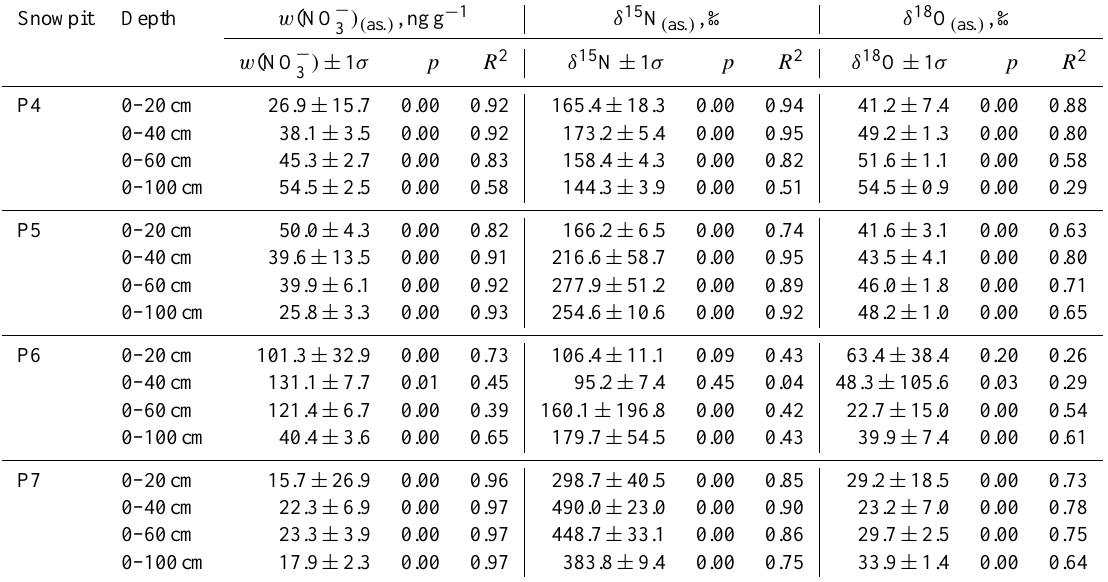
) , δ 15 N and δ 18 O of NO − Table 3. Asymptotic values of w (NO − calculated based on four different snow depth intervals (0–20, 0–40, 0–60 3 3 and 0–100cm) of each snowpit. p is the significance level of observed data fitted using the exponential regression Eq. (6), and R 2 denotes the squared correlation coefficient of observed data compared to the regression model predicted values. Also given is the standard error (1 σ) of asymptotic